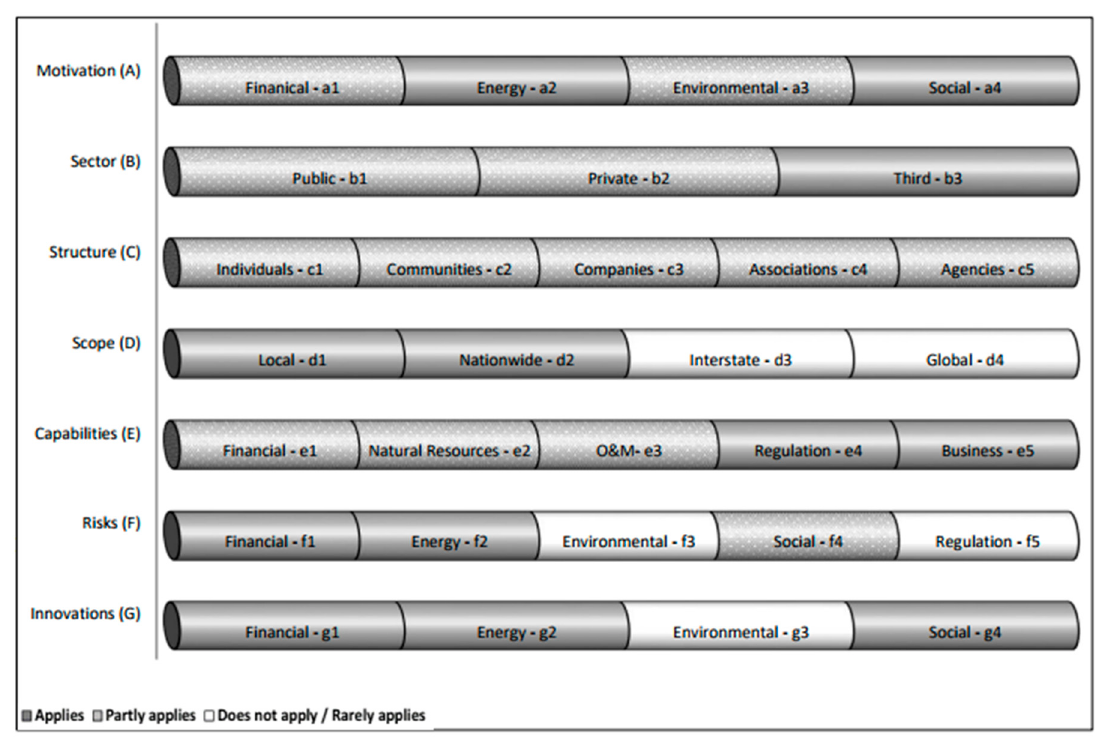
Figure 6. Schematic profile of Indian third-sector entrepreneurs.